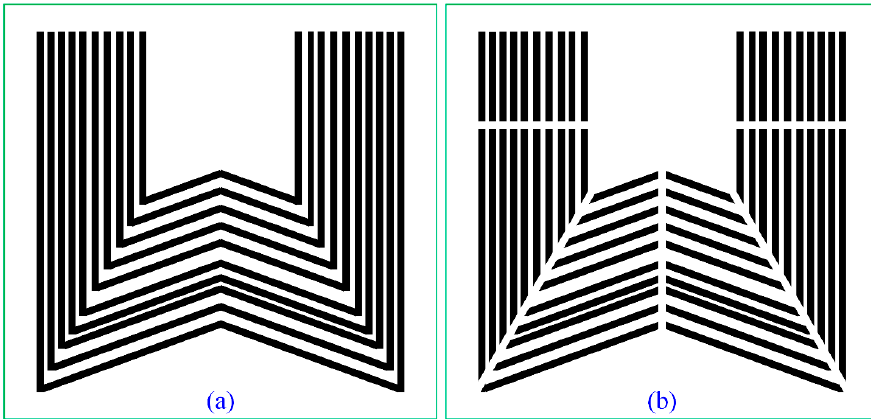
Figure 3. Structure of the proposed M-strips tag in ( a ) active mode (ID: 1111111111) and ( b ) passive mode (ID: 0000000000).